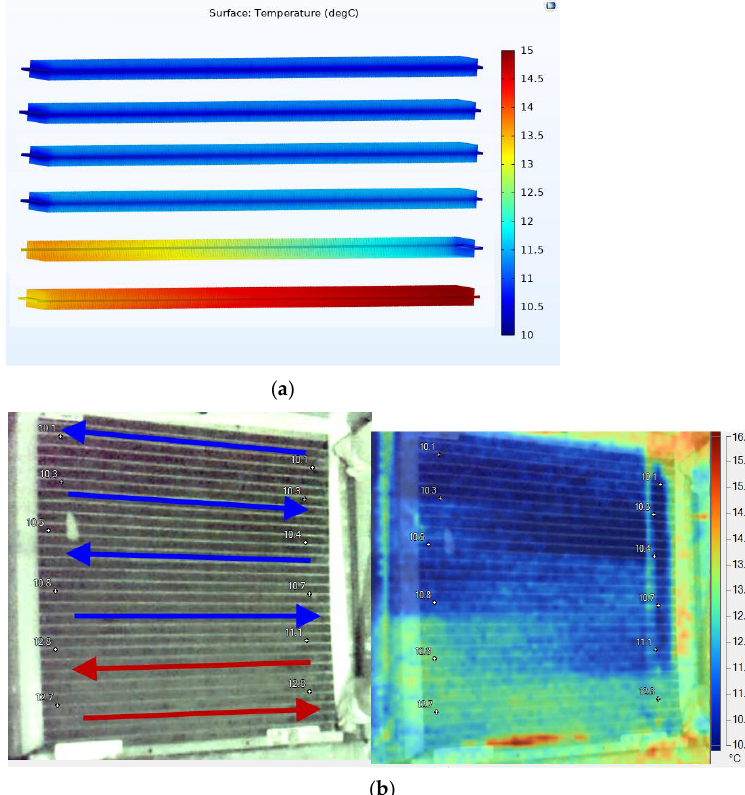
Figure 13. A comparison between the numerical simulation and experimental data. ( a ) The numer- ical results of the straight finned flat tube model; ( b ) The experimental temperature profile of the evaporator was captured by the thermal camera.